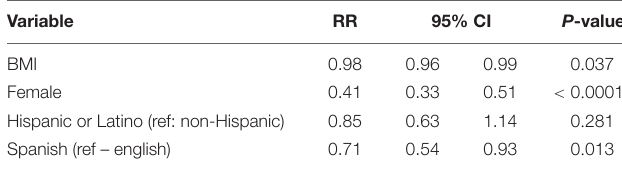
TABLE 5 | Multivariable logistic regression (relative risk) of ADHD status.